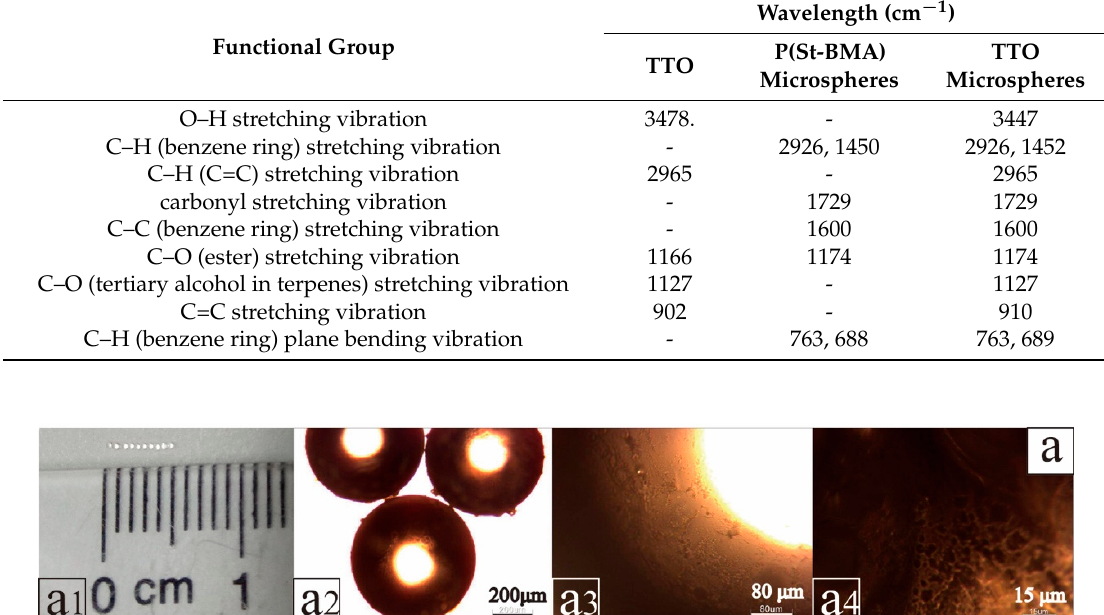
Table 1. FTIR spectra absorption peaks of TTO, P(St-BMA) microspheres, and TTO microspheres.